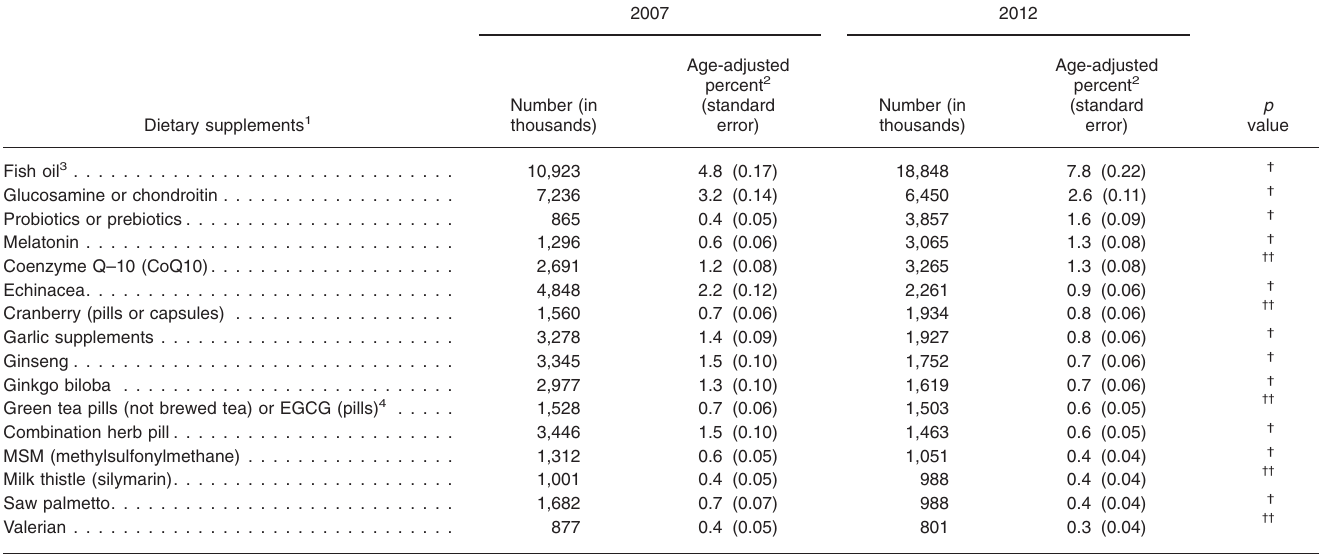
Table 3. Adults aged 18 and over who used selected types of nonvitamin, nonmineral dietary supplements during the past 30 days: United States, 2007 and